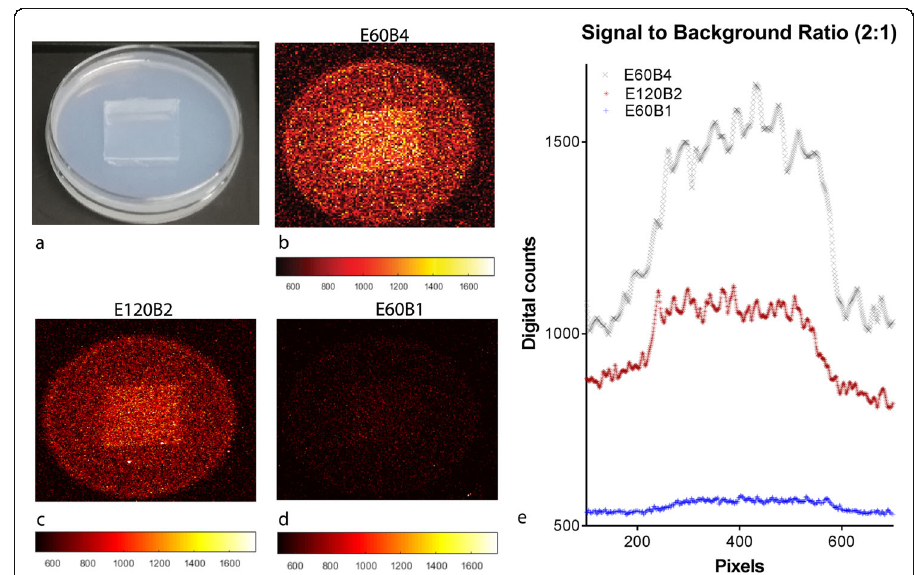
Fig. 3 A representative image of the signal-to-background ratio experiment setup ( a ). The result of three different exposure times and binning settings ( b – d ). The graph of intensity profile across the previous